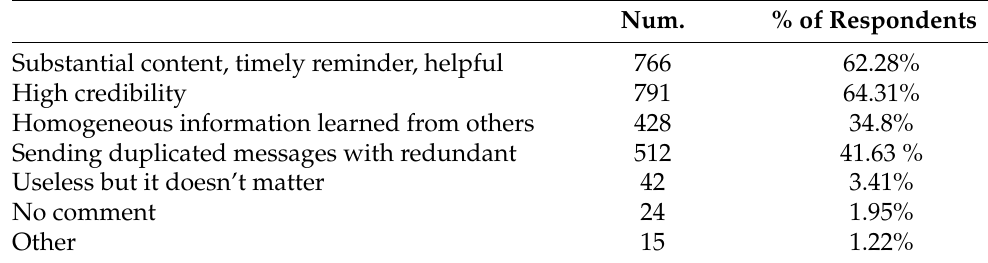
Table 3. Participants’ comments on public-interest SMS.